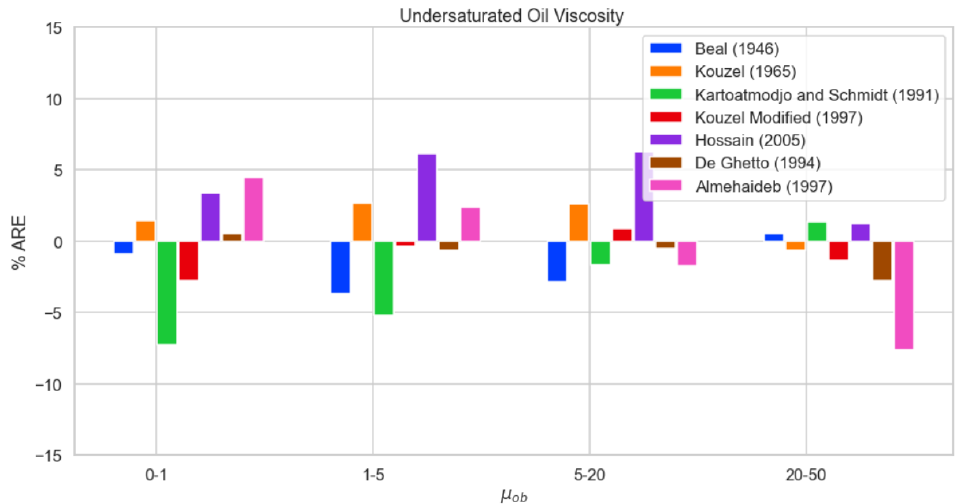
Figure 10. AARE bar plot of the most accurate correlation(s) of each